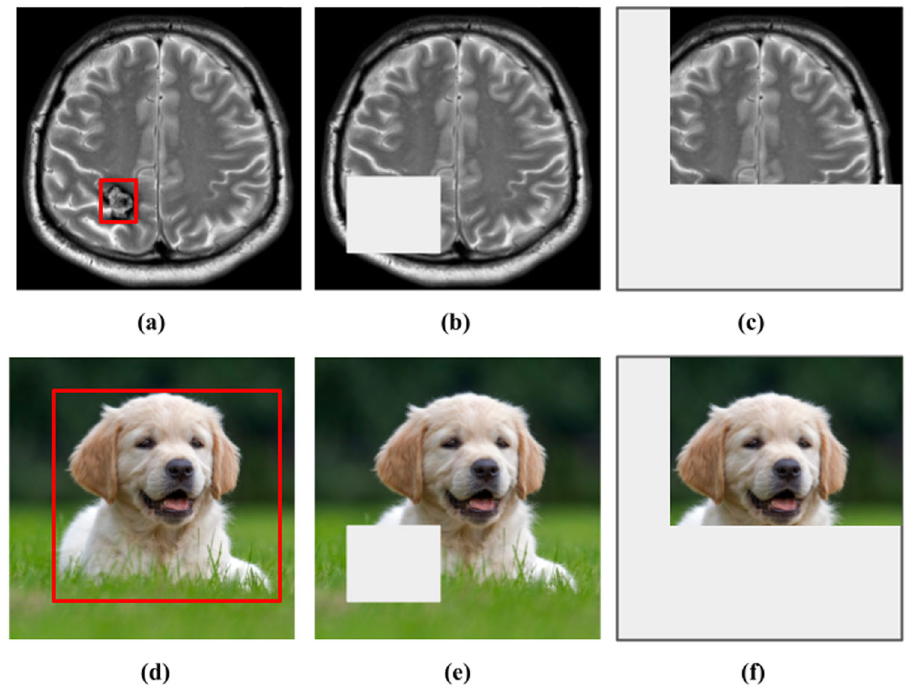
Fig. 5 Examples of augmentations and transformations that alter the semantic meaning of medical images 144 but not natural images 145 . a The image shows a T2-weighted brain MRI with a cavernoma in the right parietal lobe (bounded in red). b and c Masking and cropping operations can obscure the cavernoma and alter the semantic meaning of the image, as the MRI-scan no longer exhibits any abnormality. d Image of a dog (bounded in red), ( e ) and ( f ) Masking and cropping operations do not obscure the dog nor alter the semantic meaning of the